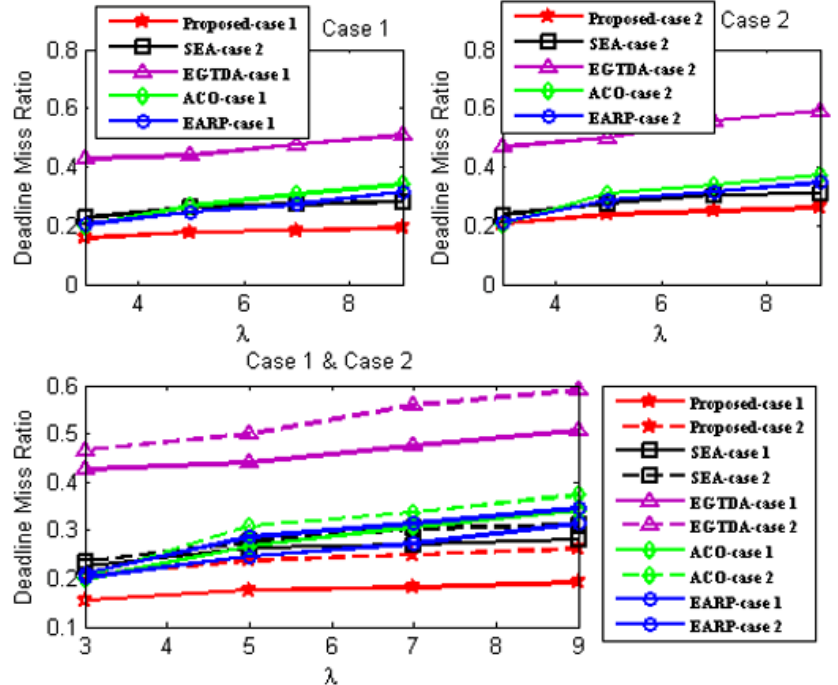
Figure 10. Influence of increasing average traffic rate on deadline miss ratio under the first scenario.